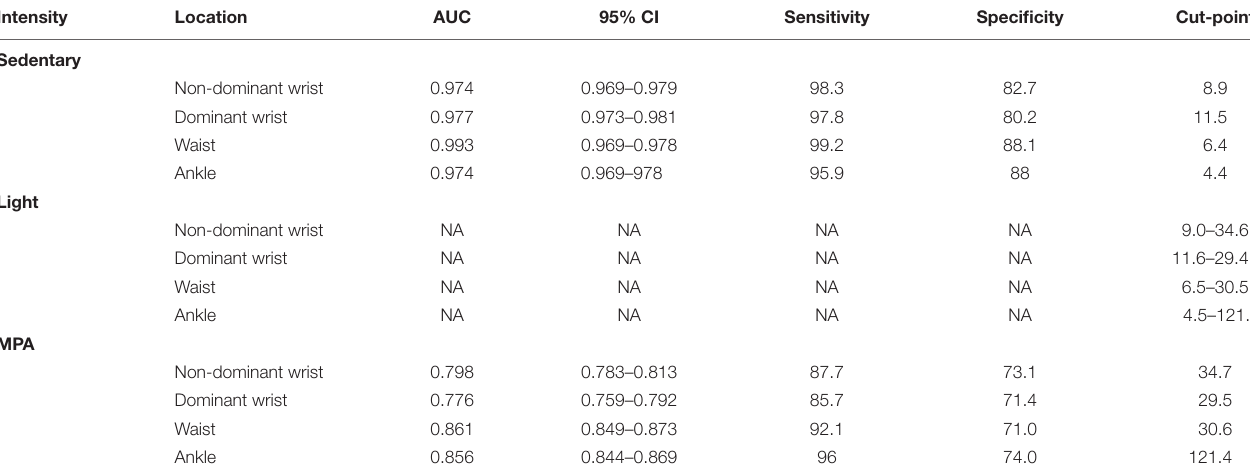
TABLE 3 | Sensitivity, specificity and area under the curve and resultant cut-points for each GENEA monitor with cycling removed from analysis. Intensity Location AUC 95% CI Sensitivity Specificity Cut-point